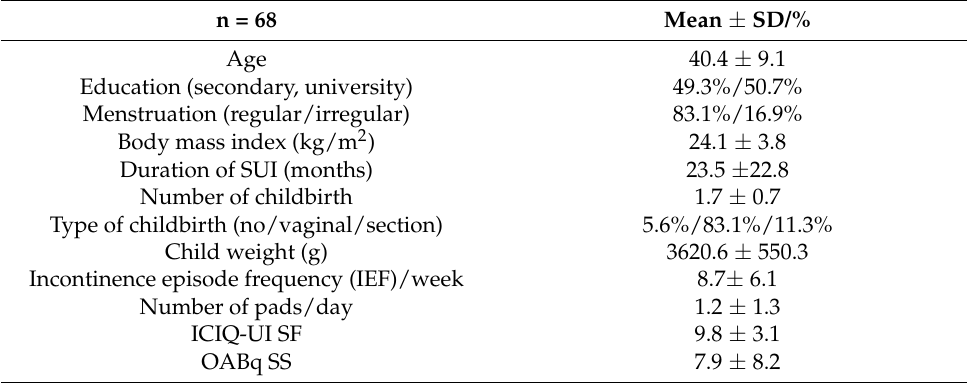
Table 1. Demographic characteristics (normal distribution).